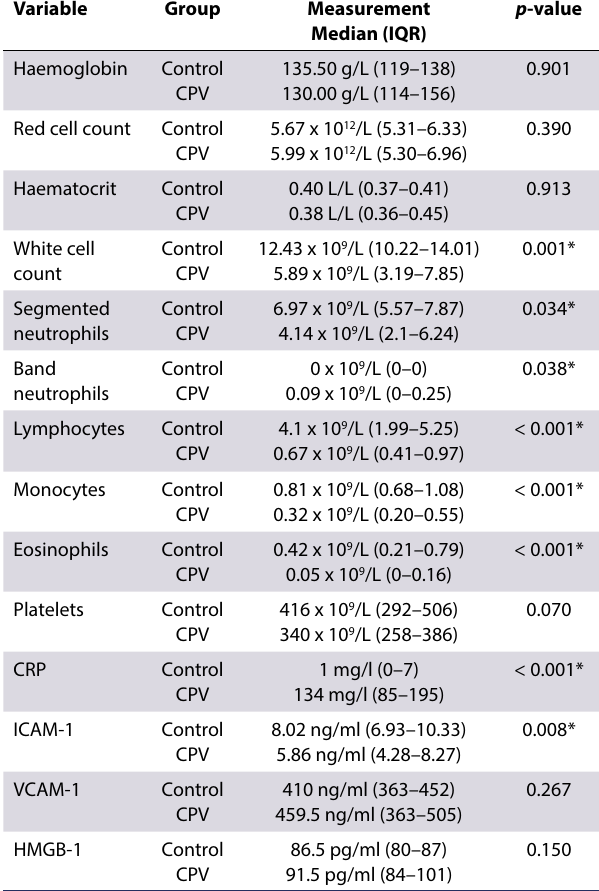
Table II: Haematology, inflammatory and circulating endothelial adhesion molecule variables in the CPV and control groups Variable